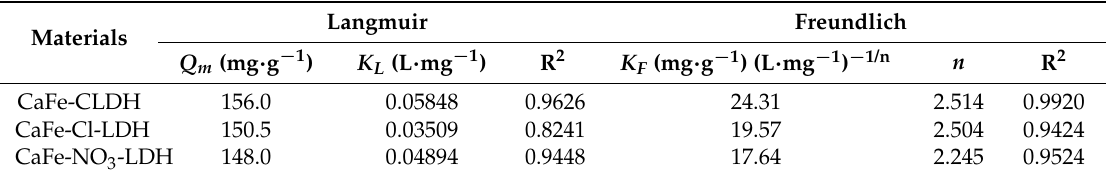
Table 2. Fitting curve parameters of arsenate adsorption isothermal equation.